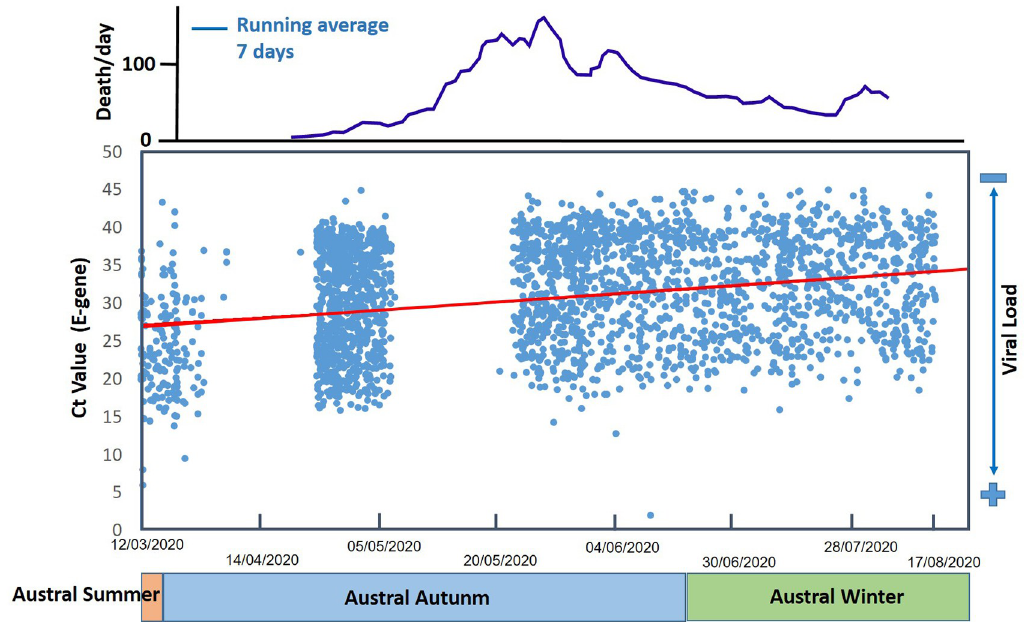
Fig 4. Seasonal behavior of Ct in a hospital of Rio de Janeiro City and Covid-19 daily mortality for the city population. (n = 15251, S2 Material).